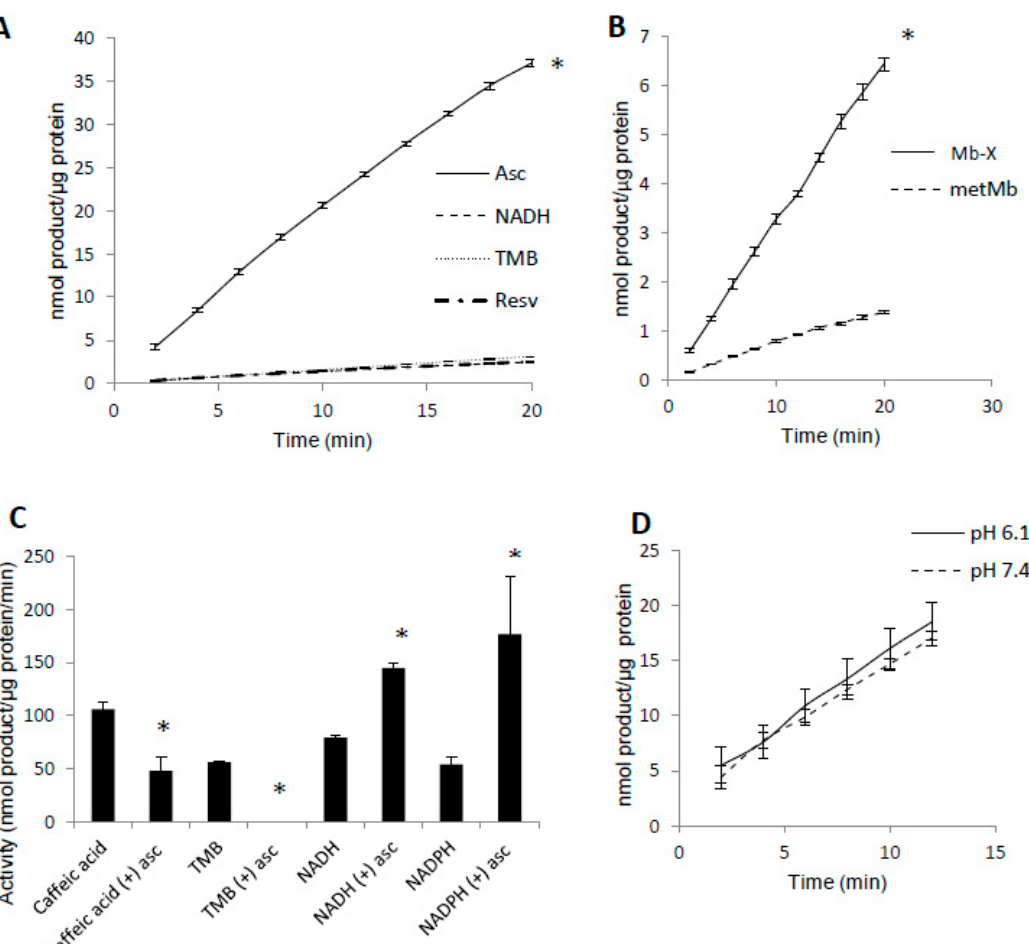
Figure 4. Mb-X species possess unique peroxidase activities compared to metMb. ( A ) Mb-X peroxidase activity was measured using ascorbic acid (Asc, 250 µM), resveratrol (Resv, 125 µM), NADH (250 µM) and TMB (500 µM) and 200 µM H 2 O 2 at pH 6.1. The activity plots for all substrates except ascorbic acid overlap, so they are not all visible. n = 6/group, * p <0.05 vs. all other groups. ( B ) Mb-X concentration was estimated as described in the methods section. Peroxidase activity with ascorbic acid was then measured with 250 µM ascorbic acid and 200 µM H 2 O 2 at pH 6.1. * p ≤ 0.05 compared to metMb, n = 3/group. ( C ) Mb-X peroxidase activity using caffeic acid (125 µM), TMB (500 µM) and NAD(P)H (250 µM) and 200 µM H 2 O 2 , pH 6.1 both in the presence and absence of 50 µM ascorbic acid. * p ≤ 0.05 compared to control without ascorbic acid, n = 3/group. ( D ) Mb-X peroxidase activity was measured at pH 7.4 and 6.1 using 250 µM ascorbic acid and 200 µM H 2 O 2 ( n = 3/group).